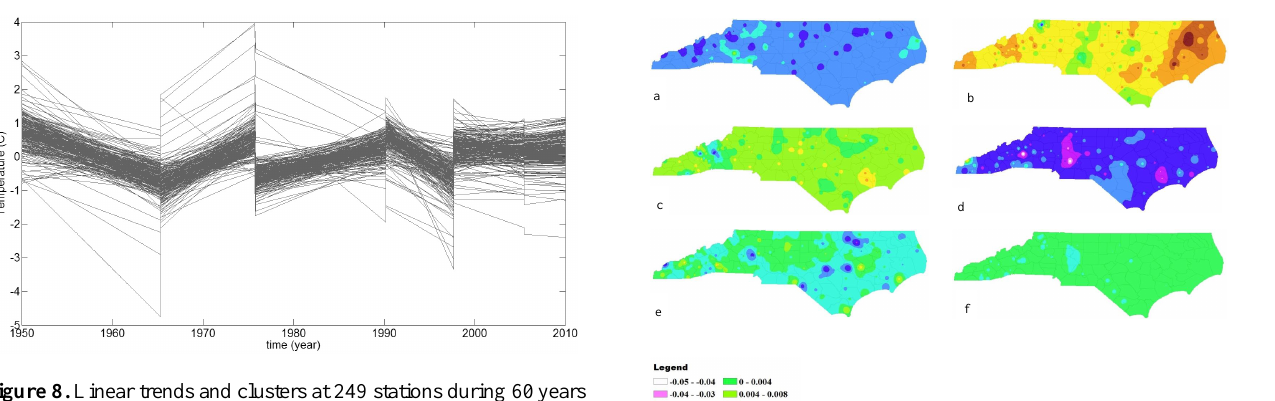
Figure 8. Linear trends and clusters at 249 stations during 60years are shown. There are two notable decreasing trends between 1950– 1964 and 1990–1998 and also a remarkable increase in 1964–1976. Other values of trends are smaller. Figure 9. Six clusters with linear trends found in NC. (a) A no- Fig. 9. Six clusters with linear trend found in NC. (a) A notable negative trend between 1950 3 table negative trend between 1950 and 1965. (b) A positive trend and 1965. (b) A positive trend after 1965. The coastal zone shows the highest warming 4 Table 3. Here are shown patterns of climate change in 60years. trend. (c) Smaller positive trend all over the state. between 1976 and 1990 (d) Negative trend 5 after 1965. The coastal zone shows the highest warming trend. (c) in 1990’s with about 8% decrease in temperature. (e) Positive trend in Piedmont and negative 6 They consist of the average temperature, the average change in tem- Smaller positive trend all over the state between 1976 and 1990. (d) trend in other parts. (f) most areas of the state have mild positive trends. 7 perature and the corresponding percentage change in temperature Negative trend in the 1990s with about 8% decrease in temperature. over 60years. Average trend is calculated by averaging between (e) Positive trend in Piedmont and negative trend in other parts. (f) trends at all 249 stations. Average temperature change is found by Most areas of the state have mild positive multiplying average trend by the length of the cluster. Percentage change is calculated by average temperature change divided by the average temperature during that cluster. Average Average trend temperature Percent Clusters Length ( ◦ C per month) change ( ◦ C) change